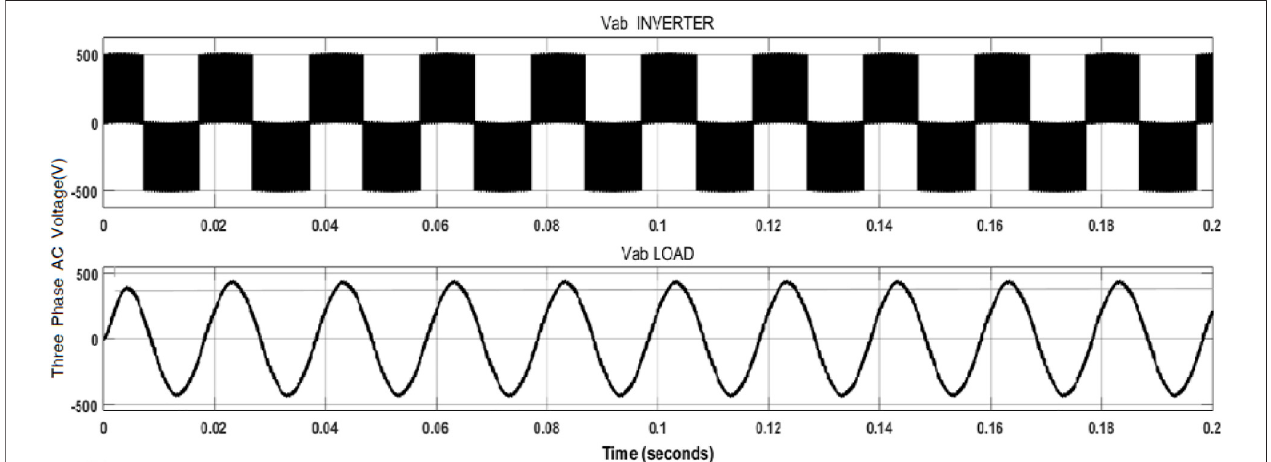
FIGURE 13 | System inverter output.